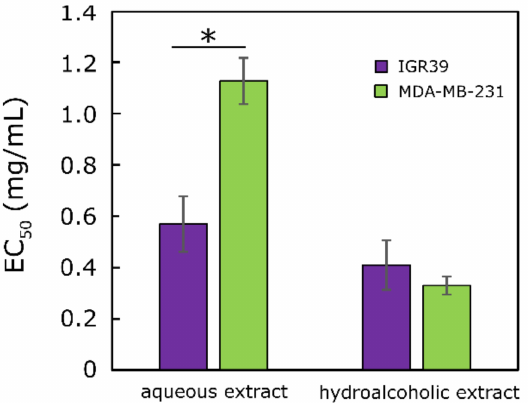
Figure 2. EC 50 values of C. sativus leaf extracts against MDA-MB-231 and IGR39 cell lines after 72 h. * p < 0.05, n =